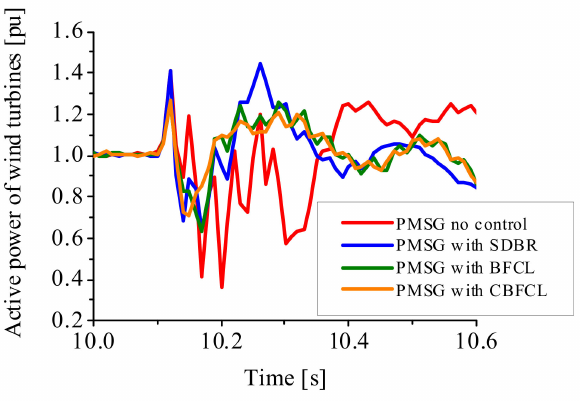
Figure 25. Active power of PMSG wind turbine.